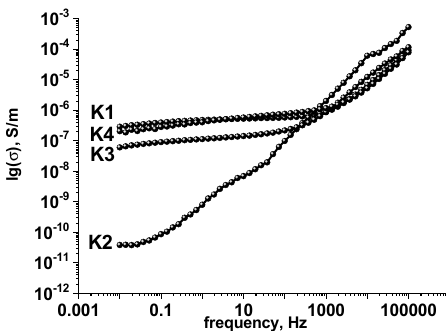
Figure 5. Frequency dependences of conductivities of synthesized materials obtained at different temperatures for samples K1, K2, K3, and K4.